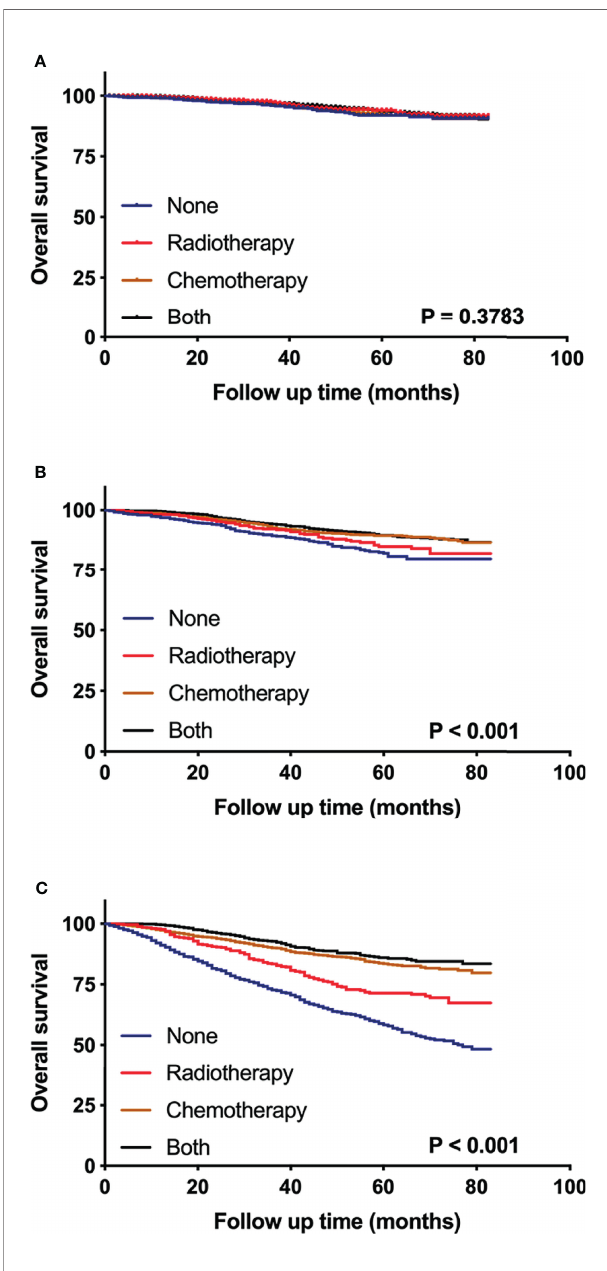
FIGURE 6 | Kaplan – Meier curves compare the survival effects of different adjuvant treatment strategies for pT1-2N0M0 TNBC patients in low-risk (A) , moderate-risk (B) , and high-risk subgroups (C) .